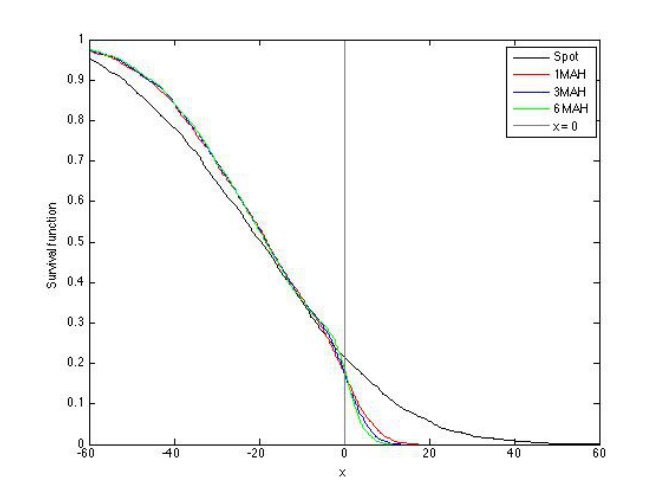
Figure 13: Empirical survival function of the difference between the price of electricity and the price of coal at time t = 335 days estimated with 10000 simulations with a time step of 1 24 days for different products (Spot, 1MAH, 3MAH, 6MAH) in the multi- barrier correlation model if the difference is equal to -20 at time t = 0 and with barriers ν = 170 and η = 170.5